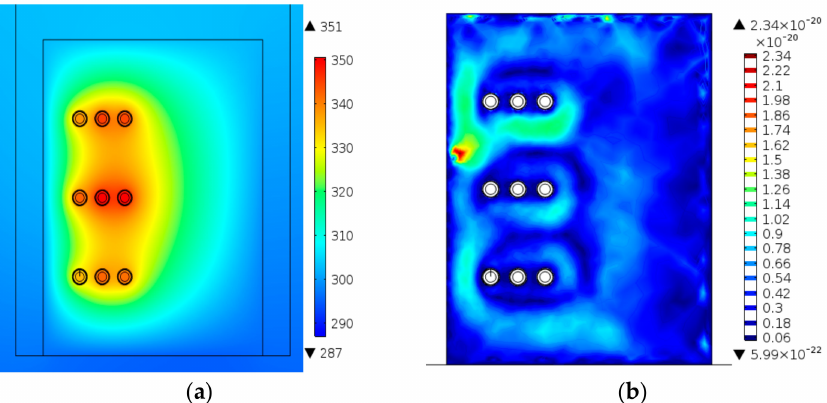
Figure 7. Temperature field and velocity distribution in trench with cable current ampacity of 481 A. ( a ) Temperature field distribution (Unit: K). ( b ) Air flow field velocity distribution (unit: m / s). Nine cables are numbered: the first layer is labeled 1, 2, and 3 from left to right. They are labeled in turn. The core temperatures are listed in Table